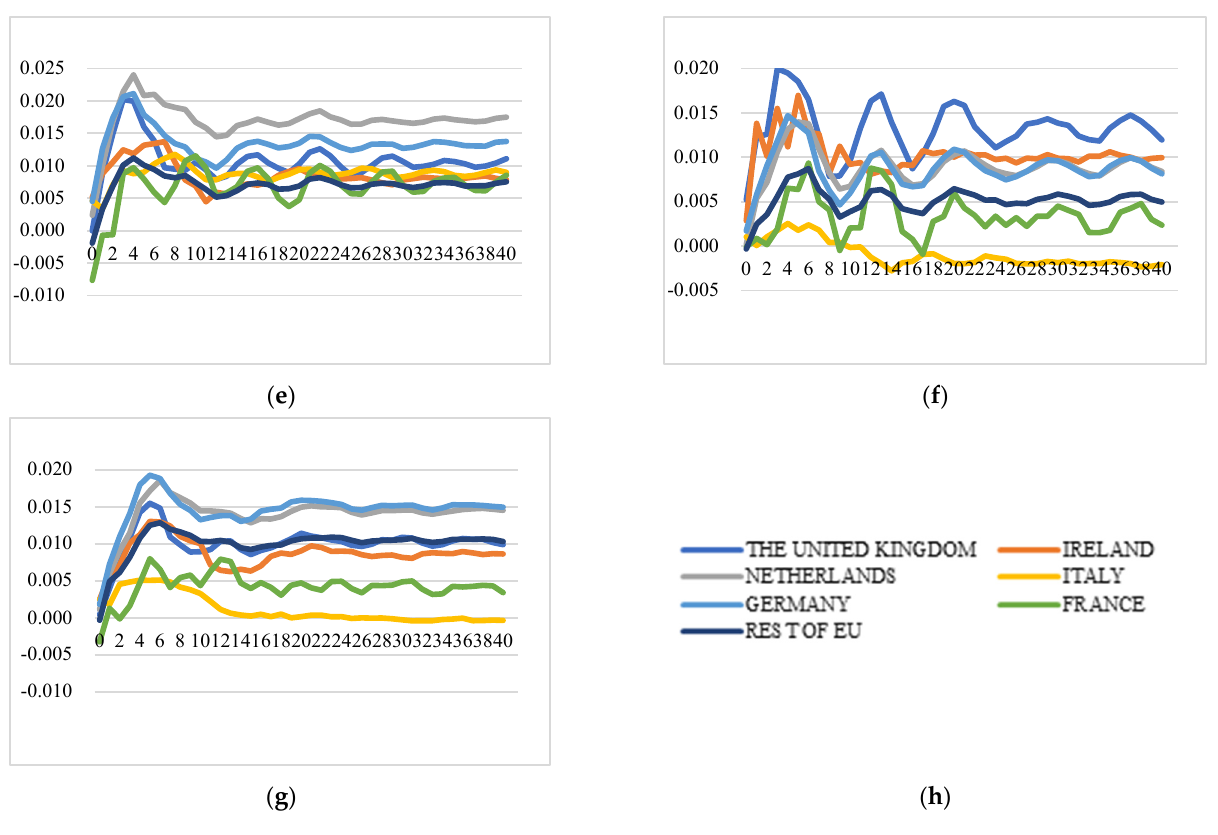
Figure 9. Generalized impulse response functions (GIRFs) of six EU member states’ intra-EU cheese export prices after a positive one-standard-error shock to raw milk price (bootstrap median estimates). ( a ) GIRFs after a shock to France’s raw milk price. ( b ) GIRFs after a shock to Germany’s raw milk price. ( c ) GIRFs after a shock to Ireland’s raw milk price. ( d ) GIRFs after a shock to Italy’s raw milk price. ( e ) GIRFs after a shock to the Netherlands’ raw milk price. ( f ) GIRFs after a shock to the UK’s raw milk price. ( g ) GIRFs after a shock to the rest of the EU’s raw milk price. ( h ) legend.